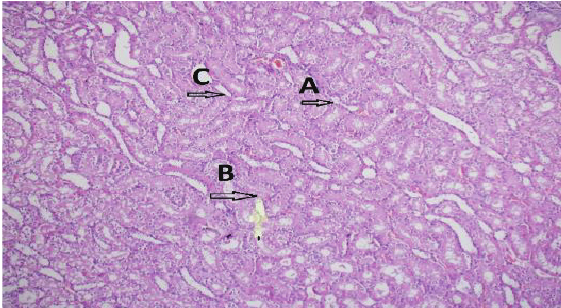
Fig-4: Rat kidney (group 4) received Cucumis melo seed ethanolic extract under 4x A.B. intact tubular epithelium C. Tubules clear of